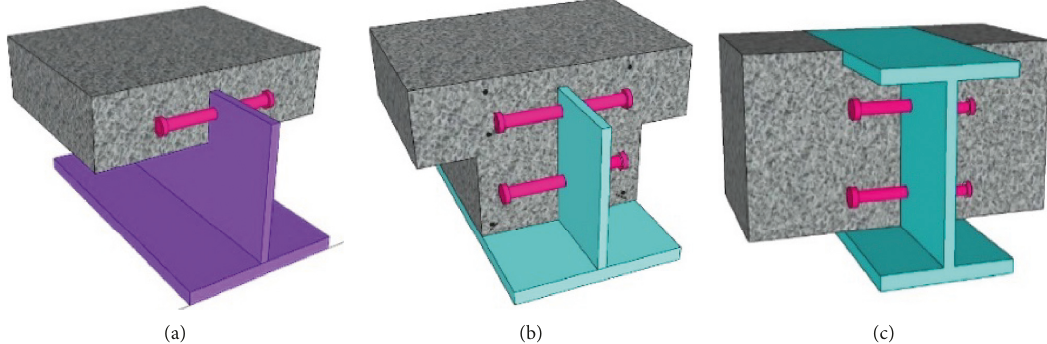
Figure 9: Headed stud welded to the web of the steel beam in the composite